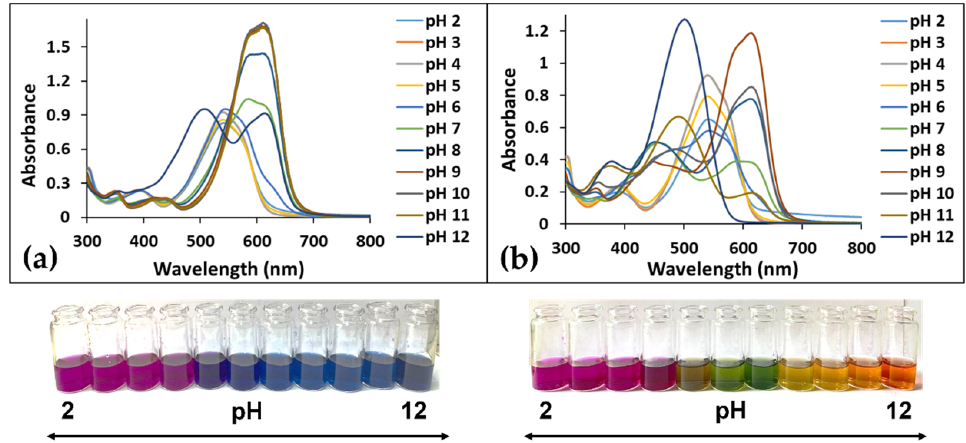
Figure 2. UV-VIS spectra and color of dye species at pH 2–12 after ( a ) 20 min and ( b ) 48 h.